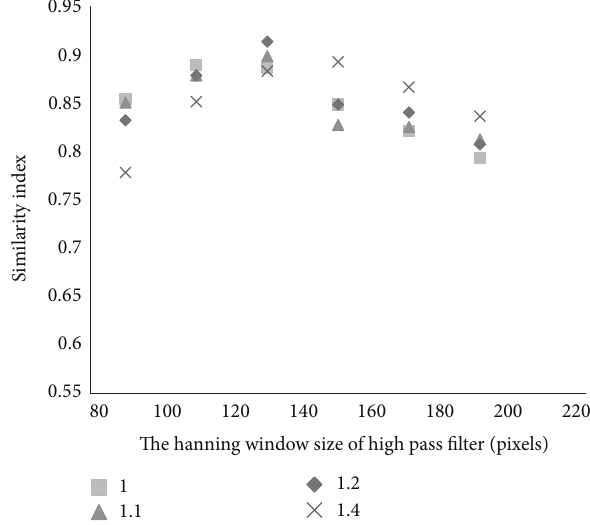
Figure 2: Receiver operating characteristic plot to determine the parameters of the high spatial frequency suppression filter.